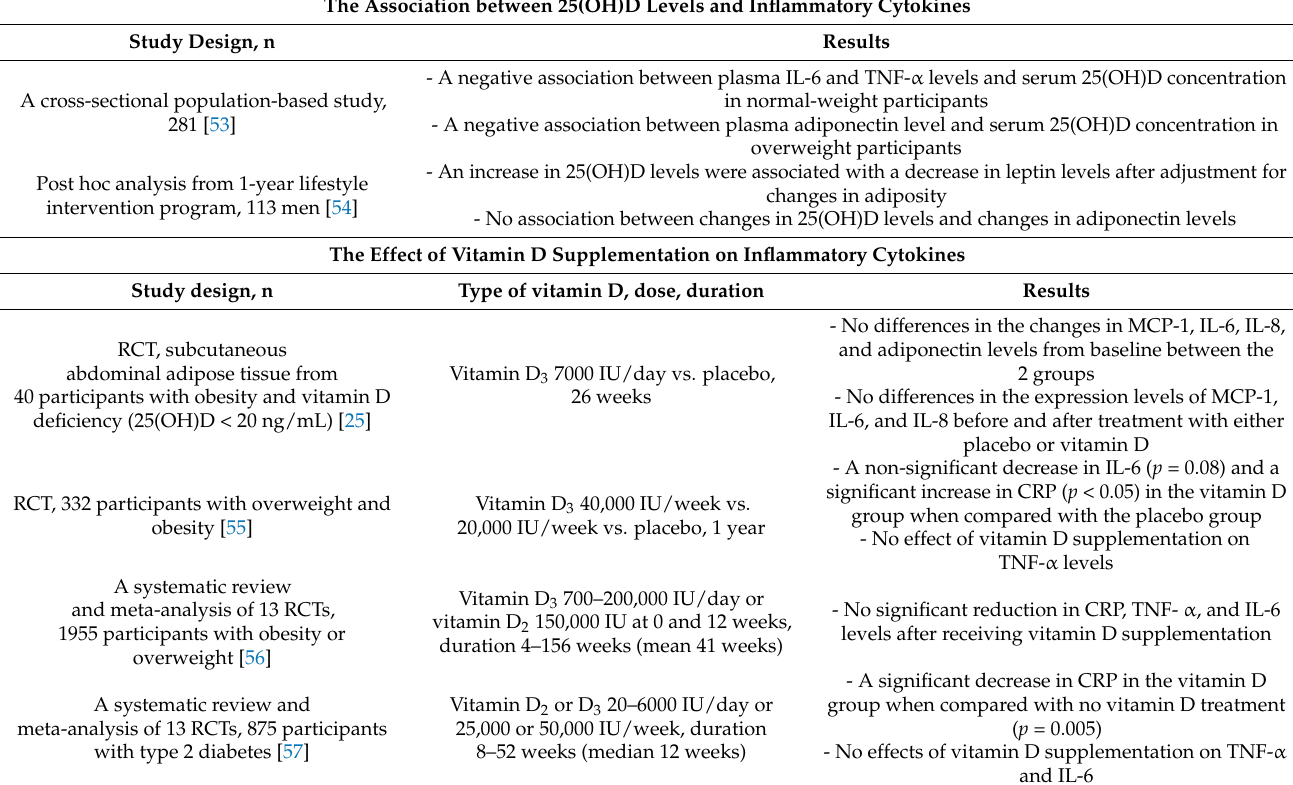
Table 3. The association between 25(OH)D levels and inflammatory cytokines and the effect of vitamin D supplementation on inflammatory cytokines in